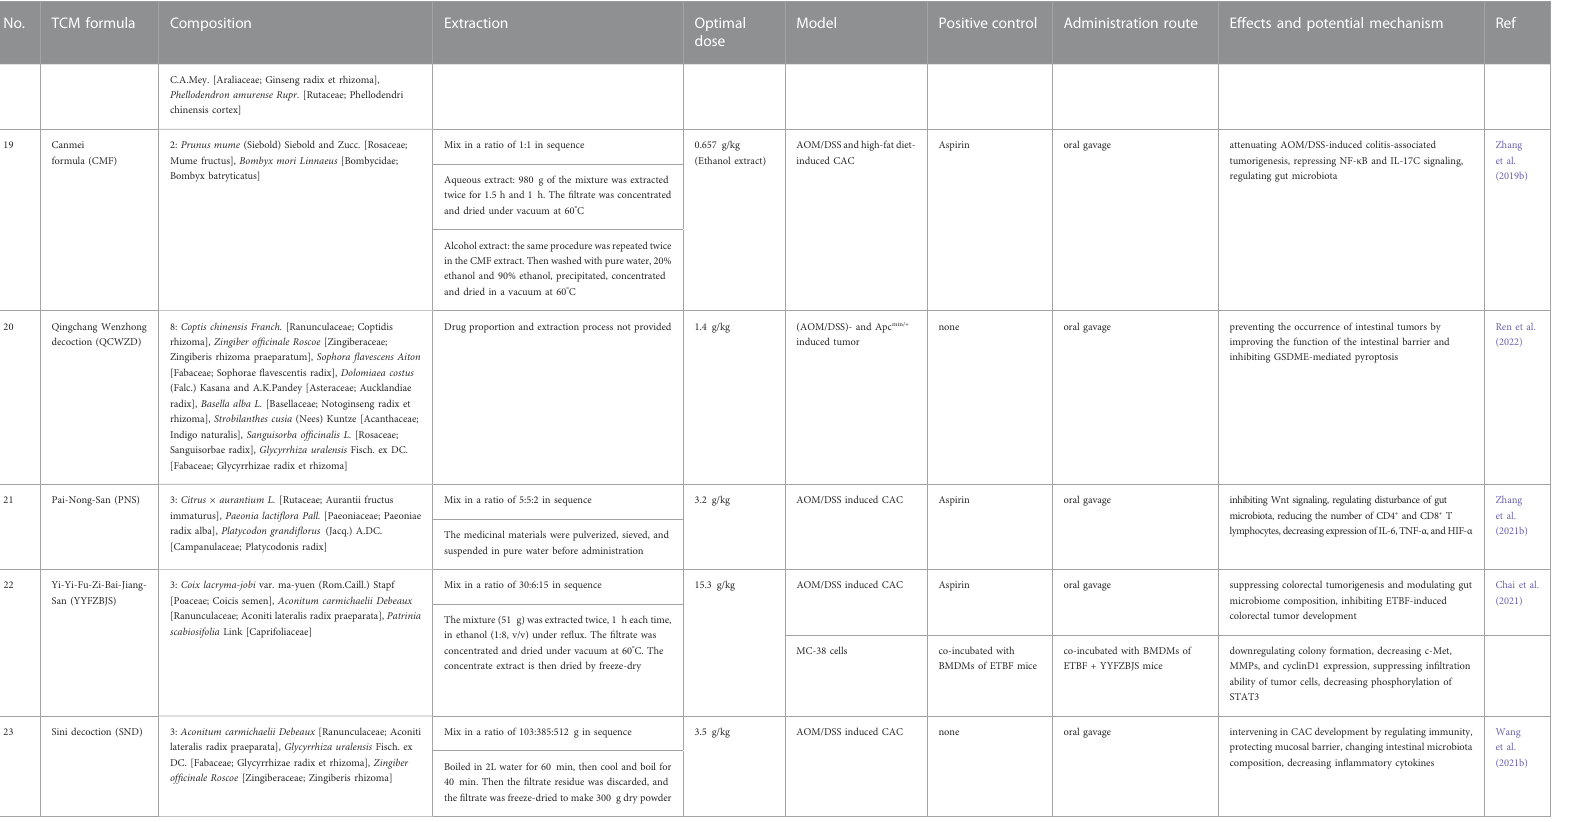
TABLE 1 ( Continued ) Lists of TCM formulas with potential anti-CAC